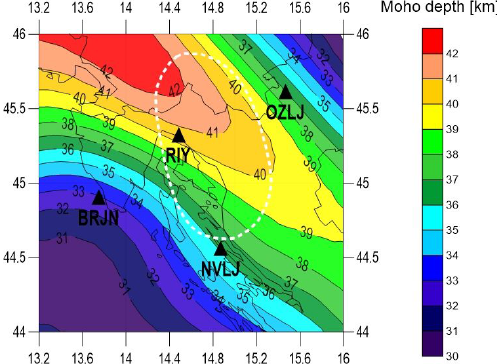
Figure 7. The Moho depth (Grad et al., 2009) at the study area. A thick white dashed line marks the contours of the northern Dinar- idic fast-velocity anomaly determined by the teleseismic tomogra- phy (ND anomaly; Šumanovac and Dudjak,